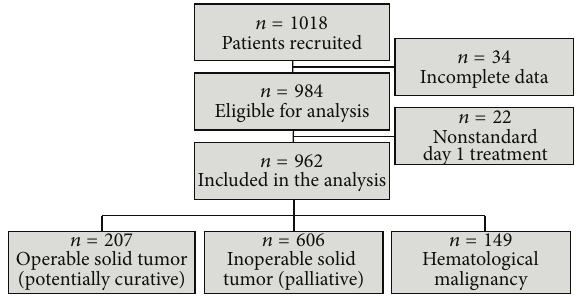
Figure 1: Patient recruitment, patient cohort, and type of disease.